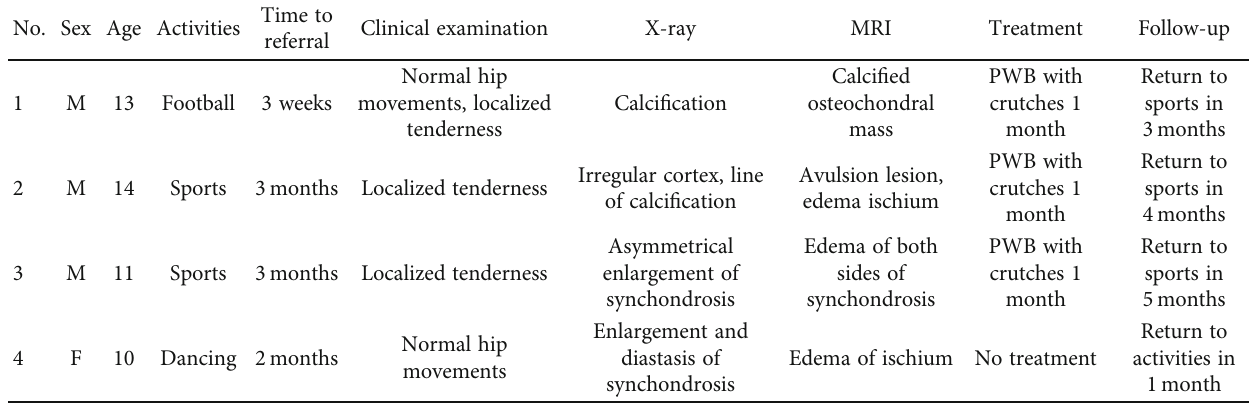
Table 1: Patient demographic data, clinical and radiological fi ndings, and